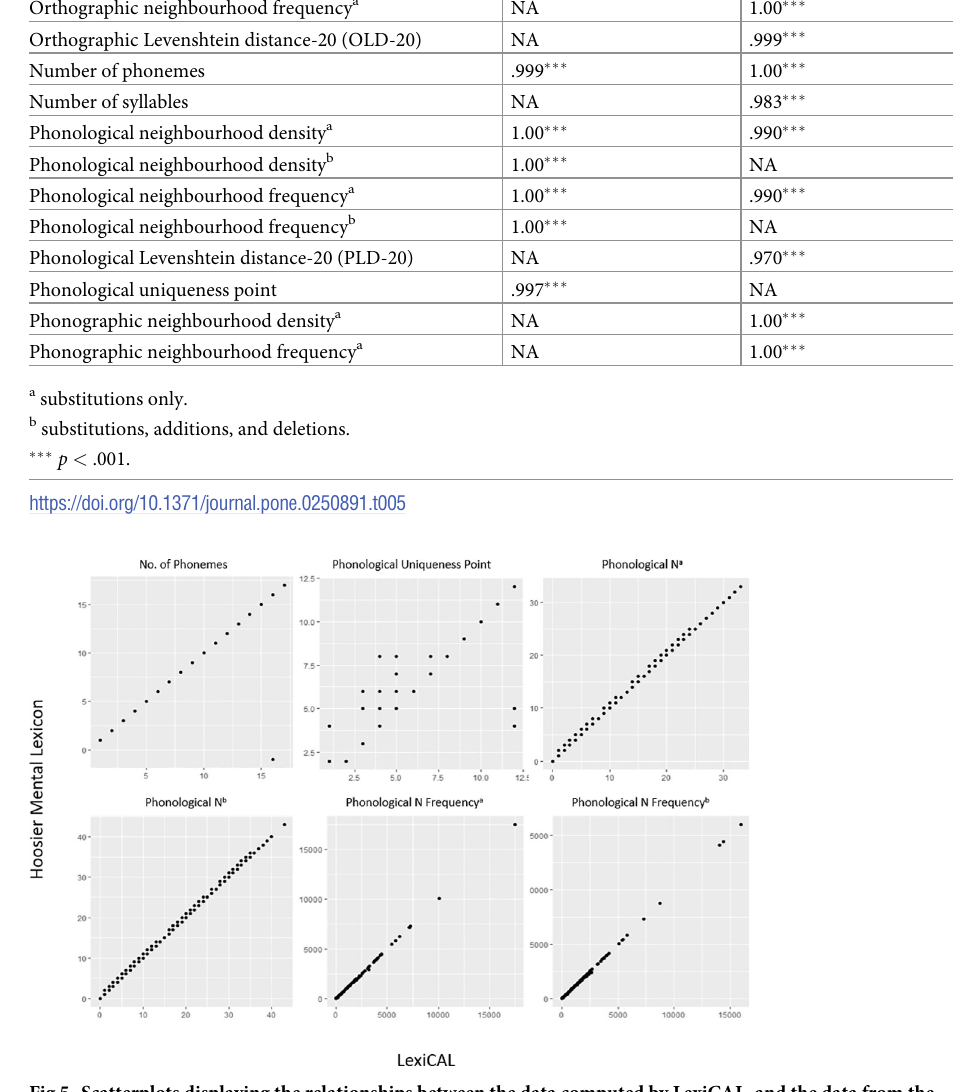
Fig 5. Scatterplots displaying the relationships between the data computed by LexiCAL, and the data from the Hoosier Mental Lexicon. a substitutions only; b substitutions, additions, and